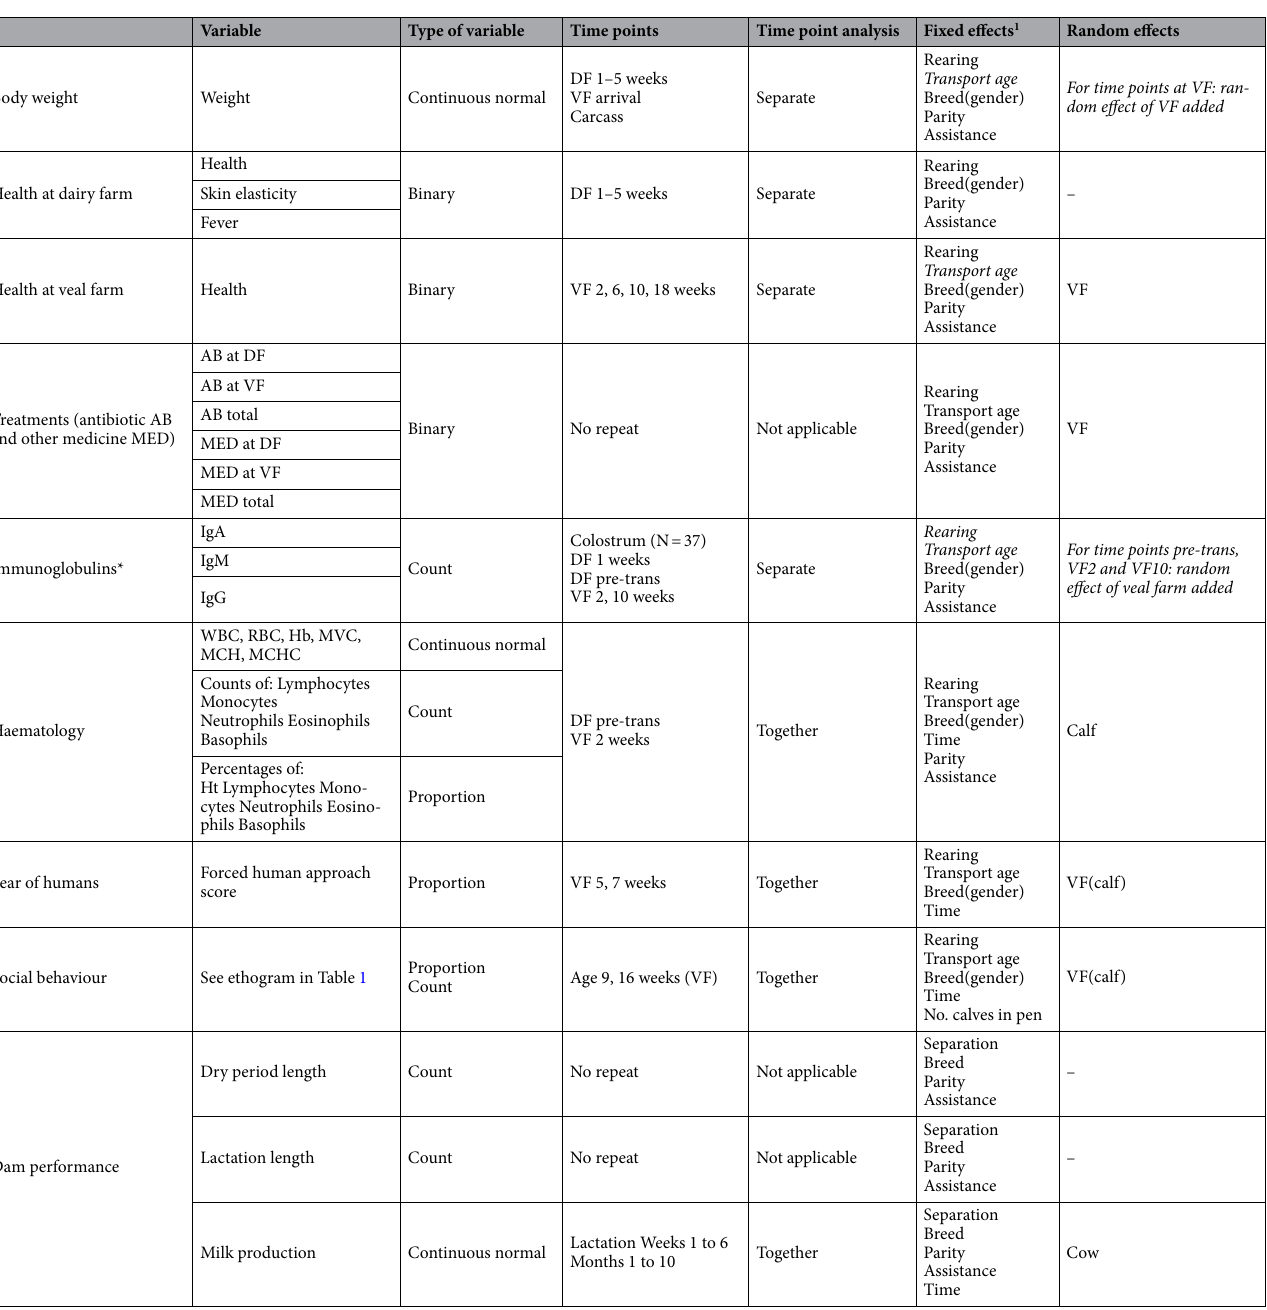
Table 2. Summary of the statistical analyses carried out in this study, including a description of response variables, time points and fixed effects. Abbreviations are described under the table. DF = Dairy